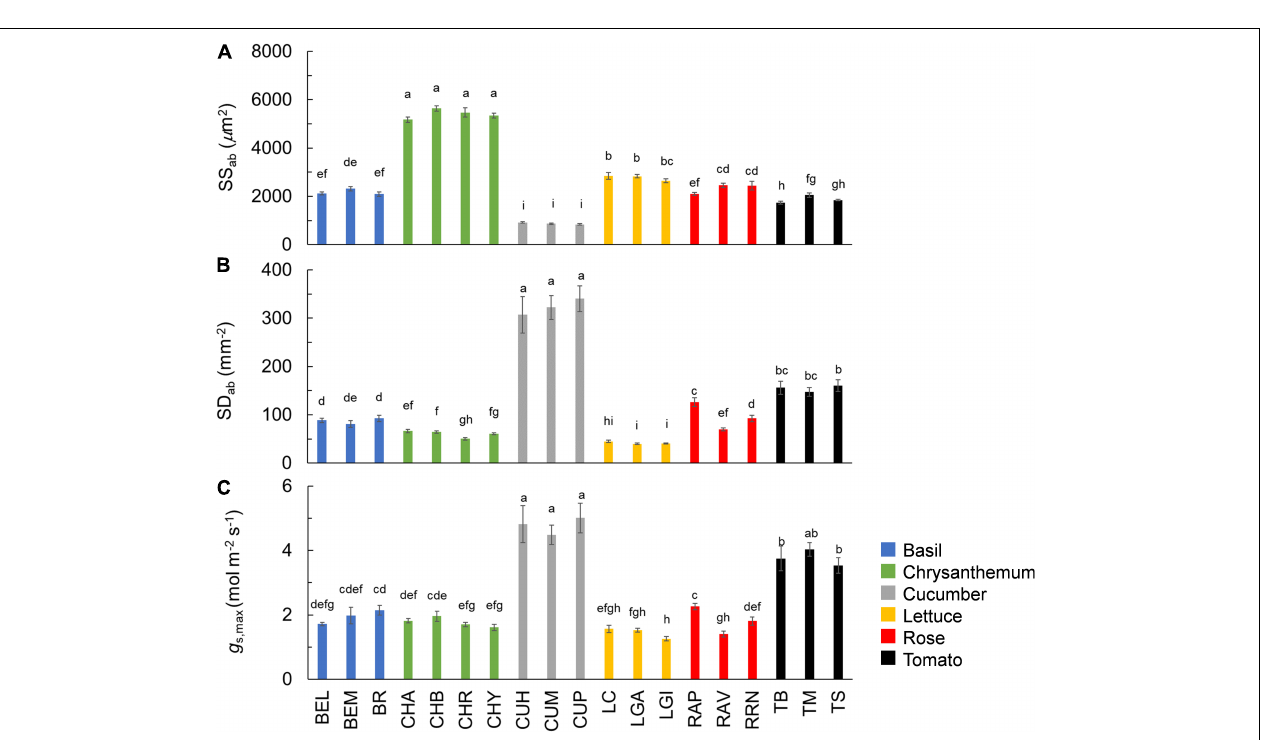
FIGURE 5 | Stomatal size ( A ; SS ab ) and density ( B ; SD ab ) at the abaxial leaf side, and theoretical maximum stomatal conductance ( C ; g s , max ) of all 19 horticultural genotypes. Colors indicate crop species. Bars show means ± SE ( n = 7–9). Letters indicate significant differences ( p < 0.05). Statistical test results of SS ab , SD ab , and g s , max were based on log-transformation of the data. Refer to Table 1 for full genotype